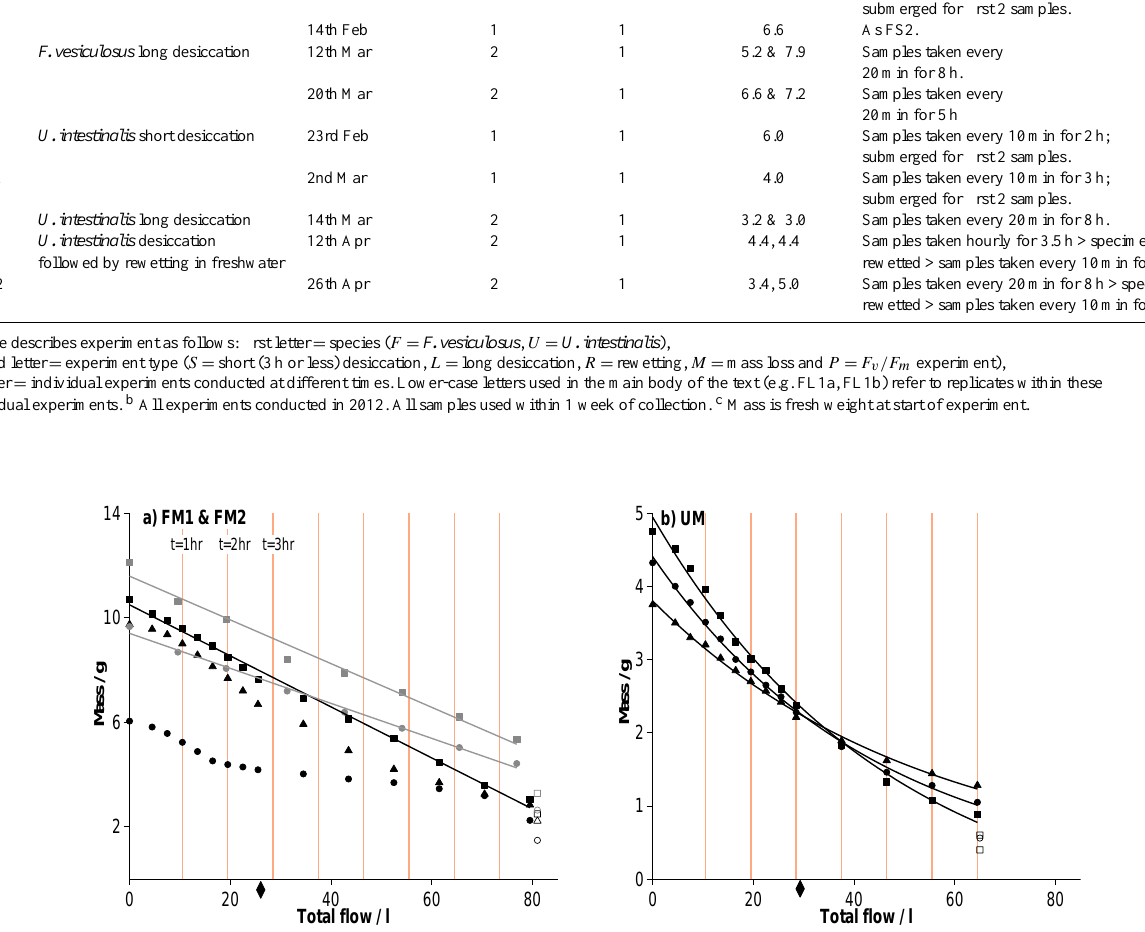
Figure 2. Mass (water) loss during desiccation of (a) F. vesiculosus (FM1 in black and FM2 in grey) and (b) U. intestinalis (UM). For details of replicates see Table 1, individual replicates are denoted by different marker shapes. Open shapes show dry mass of each sample (see Sect. 2.1). Vertical lines = 1h intervals from start (0h) of desiccation. (cid:7) = time experimental procedure switched from sampling 3 times an hour to sampling once per hour (see Sect. 2.4). Patterns in mass loss are discussed further in Sect. 3.1; loss in U. intestinalis (b) has been represented with an exponential decay curve. Loss in F. vesiculosus was more varied, however some replicates showed a linear loss of mass (see Sect. 3.1 for more